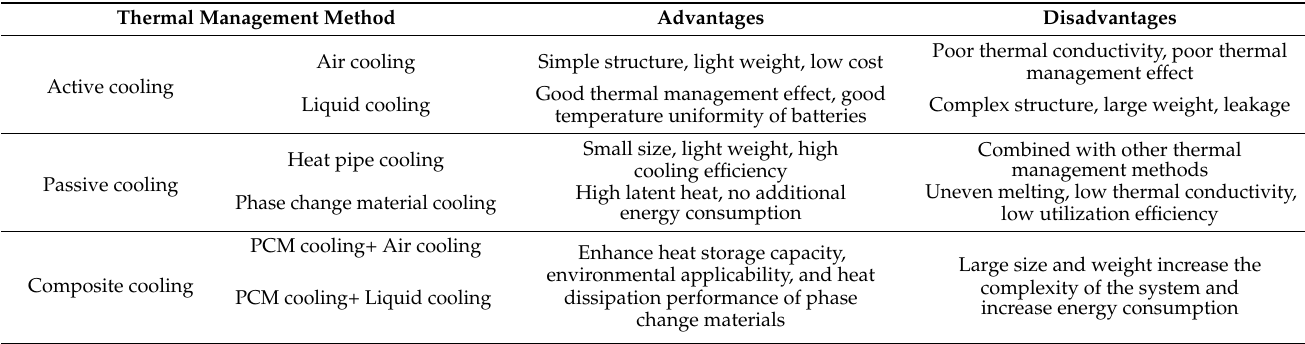
Table 1. Comparison of battery thermal management